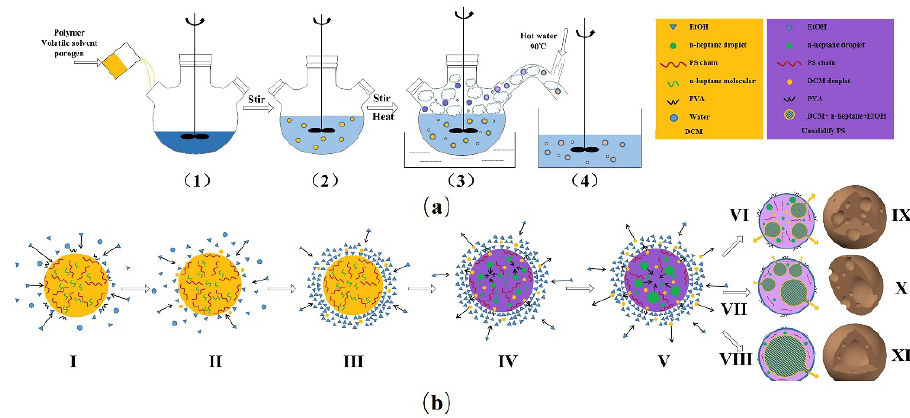
Figure 3. ( a ) Schematic diagrams of the process to prepare polymeric microspheres; ( b ) the